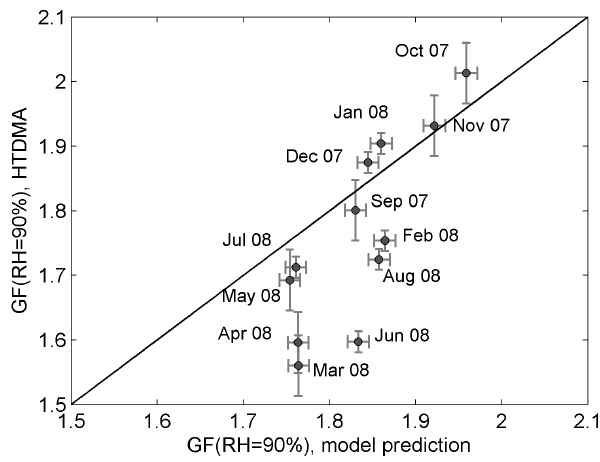
Figure 4. Comparison of calculated monthly growth factors using the hygroscopic model and the sampled H-TDMA measurements at RH = 90% for aerosol particles in the size range of 80–120nm, from September 2007 to August